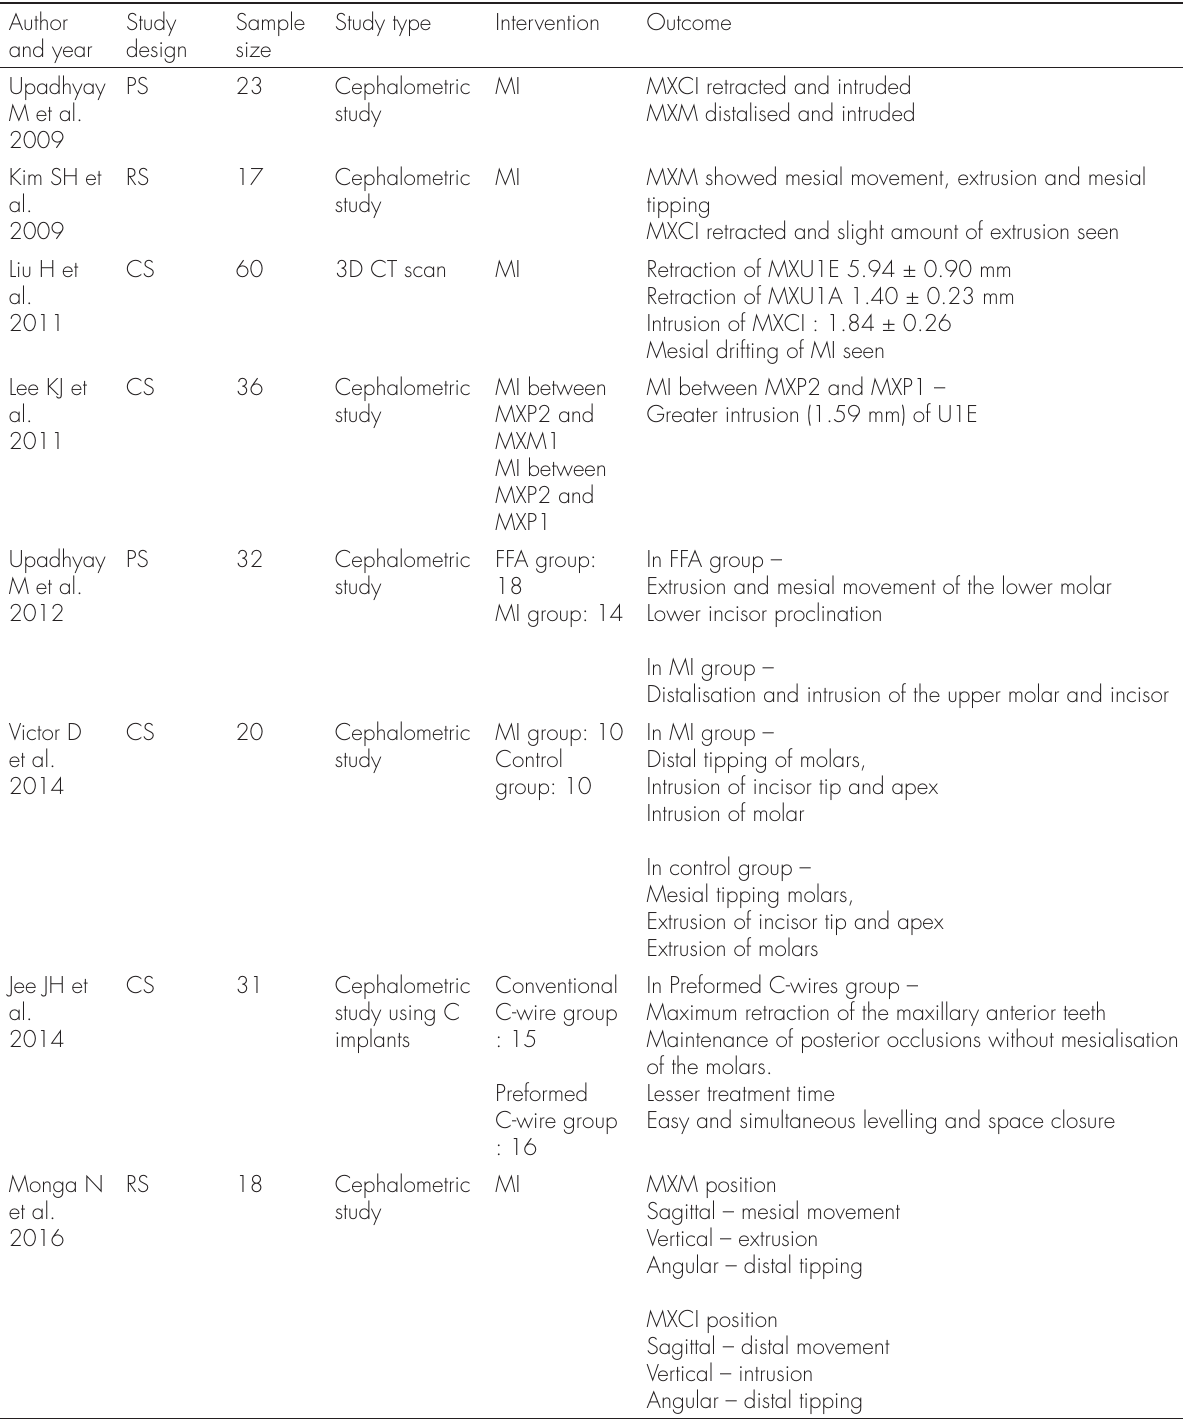
Table VIII. Effectiveness of mini-implants